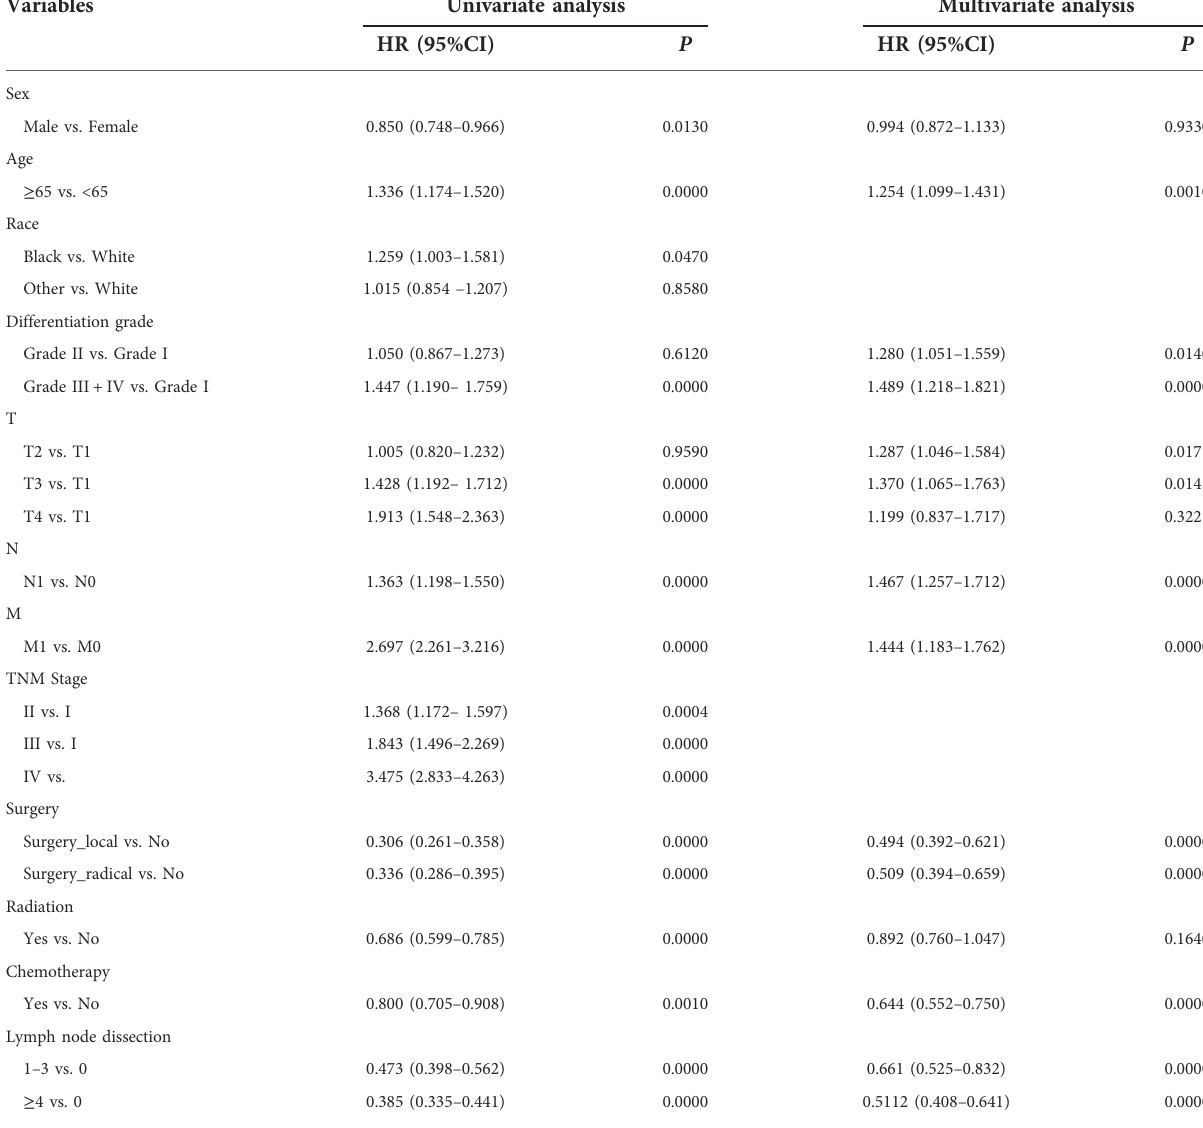
TABLE 2 Univariate and multivariate Cox analysis of clinical characteristics of patients with pCCA in training